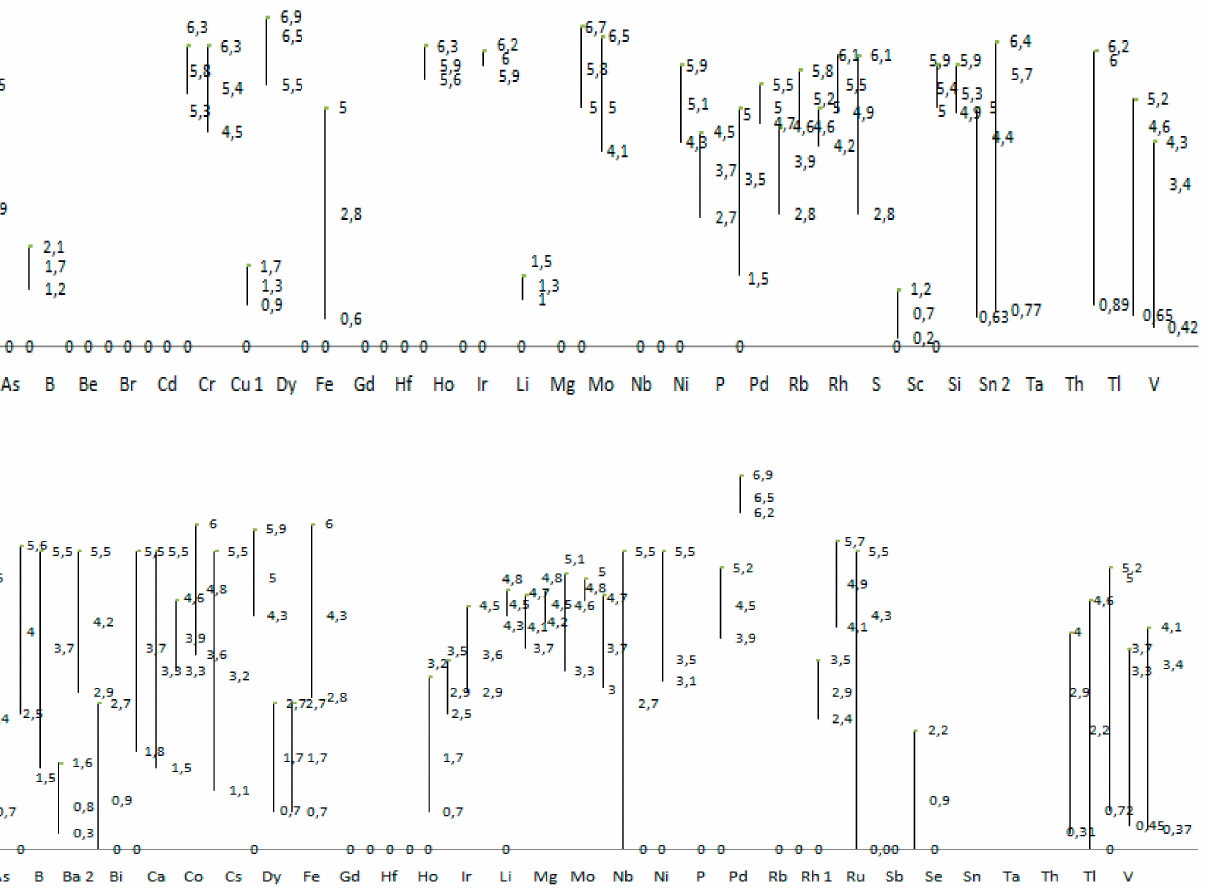
Figure 2. Graphical presentation of distribution of elements determined by stationary phase silicagel F 256 ( above ) and cellulose F ( below